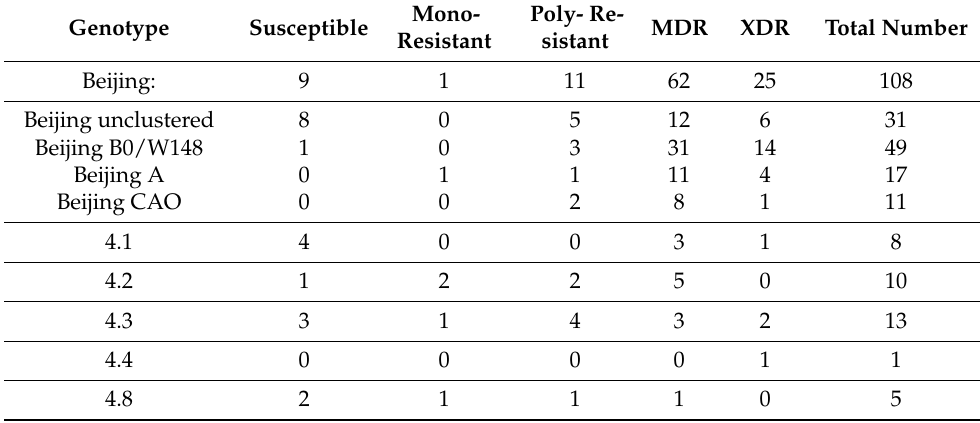
Table 3. Characterization of drug susceptibility in different M. tuberculosis genetic clades (n). Genotype Susceptible